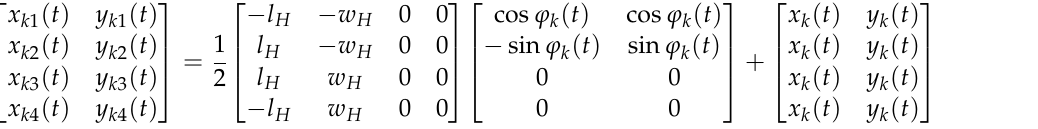
Figure 6. ( a ) Point P is outside the rectangle; ( b ) Point P is inside the rectangle.